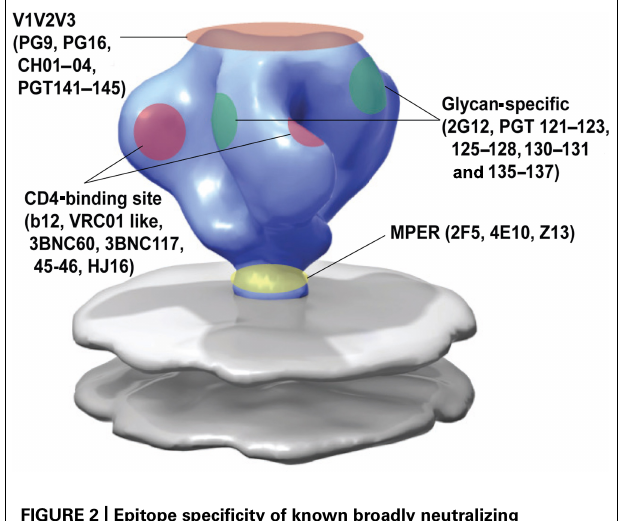
FIGURE 2 | Epitope specificity of known broadly neutralizing antibodies to HIV-1 envelope. Adapted fromWhite etal. (2010).